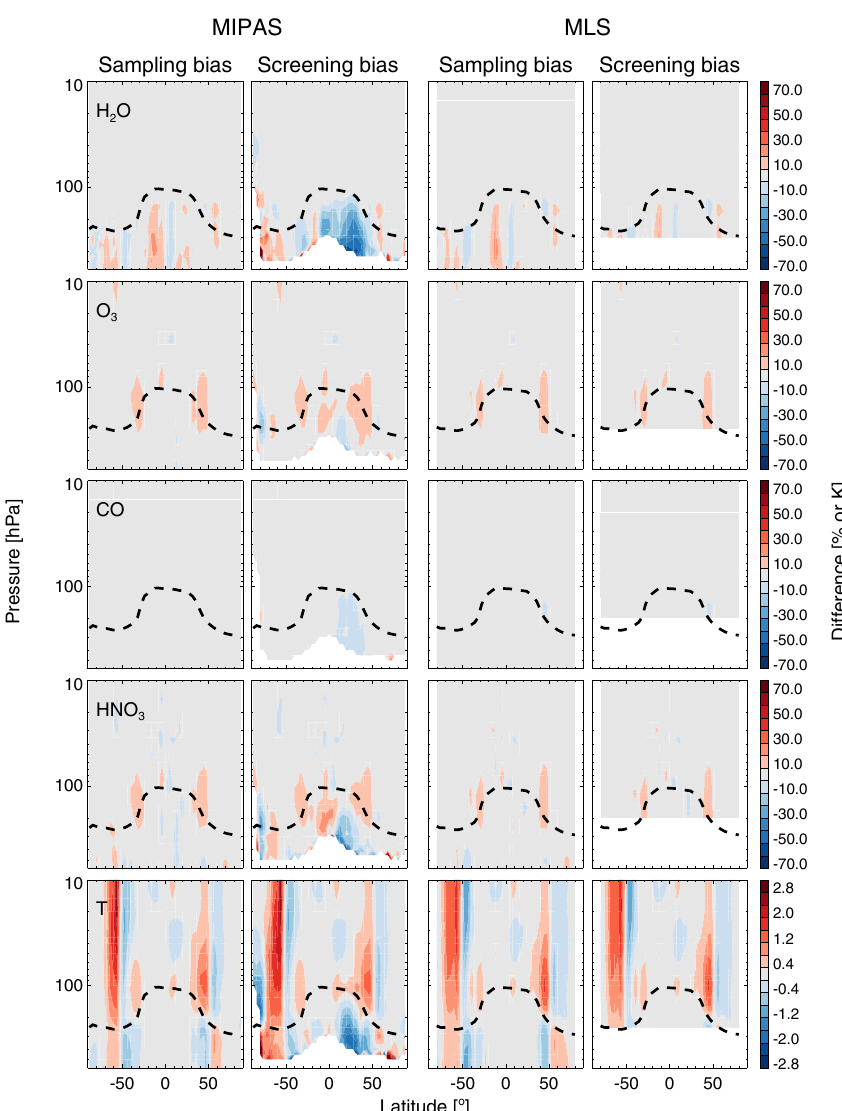
Figure 3. June 2005 sampling and quality screening biases as a function of latitude and pressure for H 2 O, O 3 , CO, HNO 3 , and temperature as measured using MIPAS and MLS. White regions denote a lack of measurements. The dashed black lines show the mean June 2005 thermal tropopause derived from